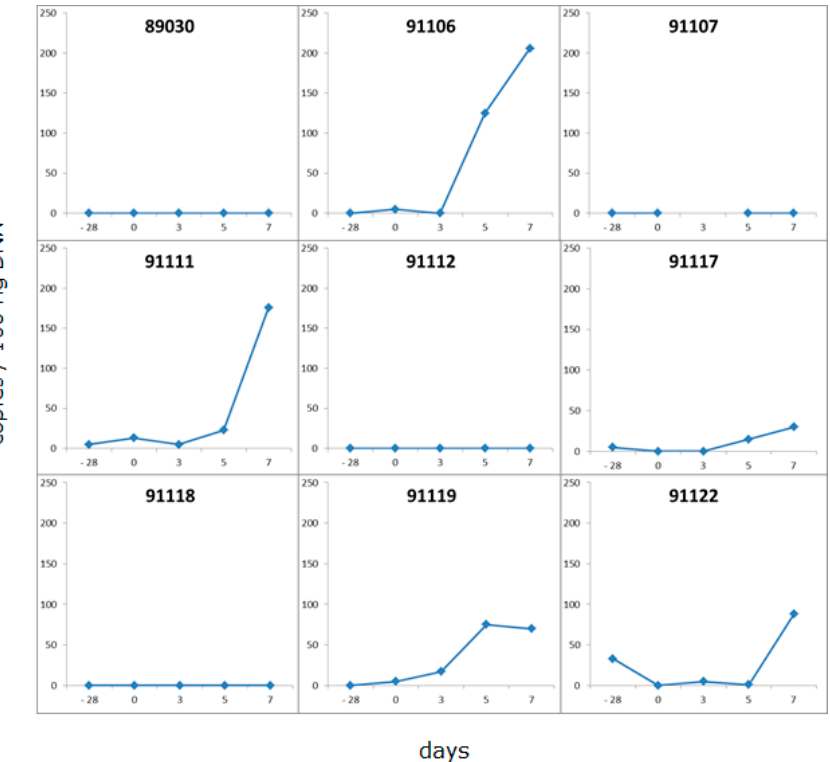
Figure 3. Real-time PCR analysis of PBMCs from PCMV-infected pigs before and after incubation in culture medium. Ficoll gradient-isolated PBMCs were incubated in culture medium for five days; DNA was isolated before and after incubation, and tested for PCMV. The value 0 at day − 28 indicates the absence of PCMV in blood samples taken 28 days before the incubation experiment.